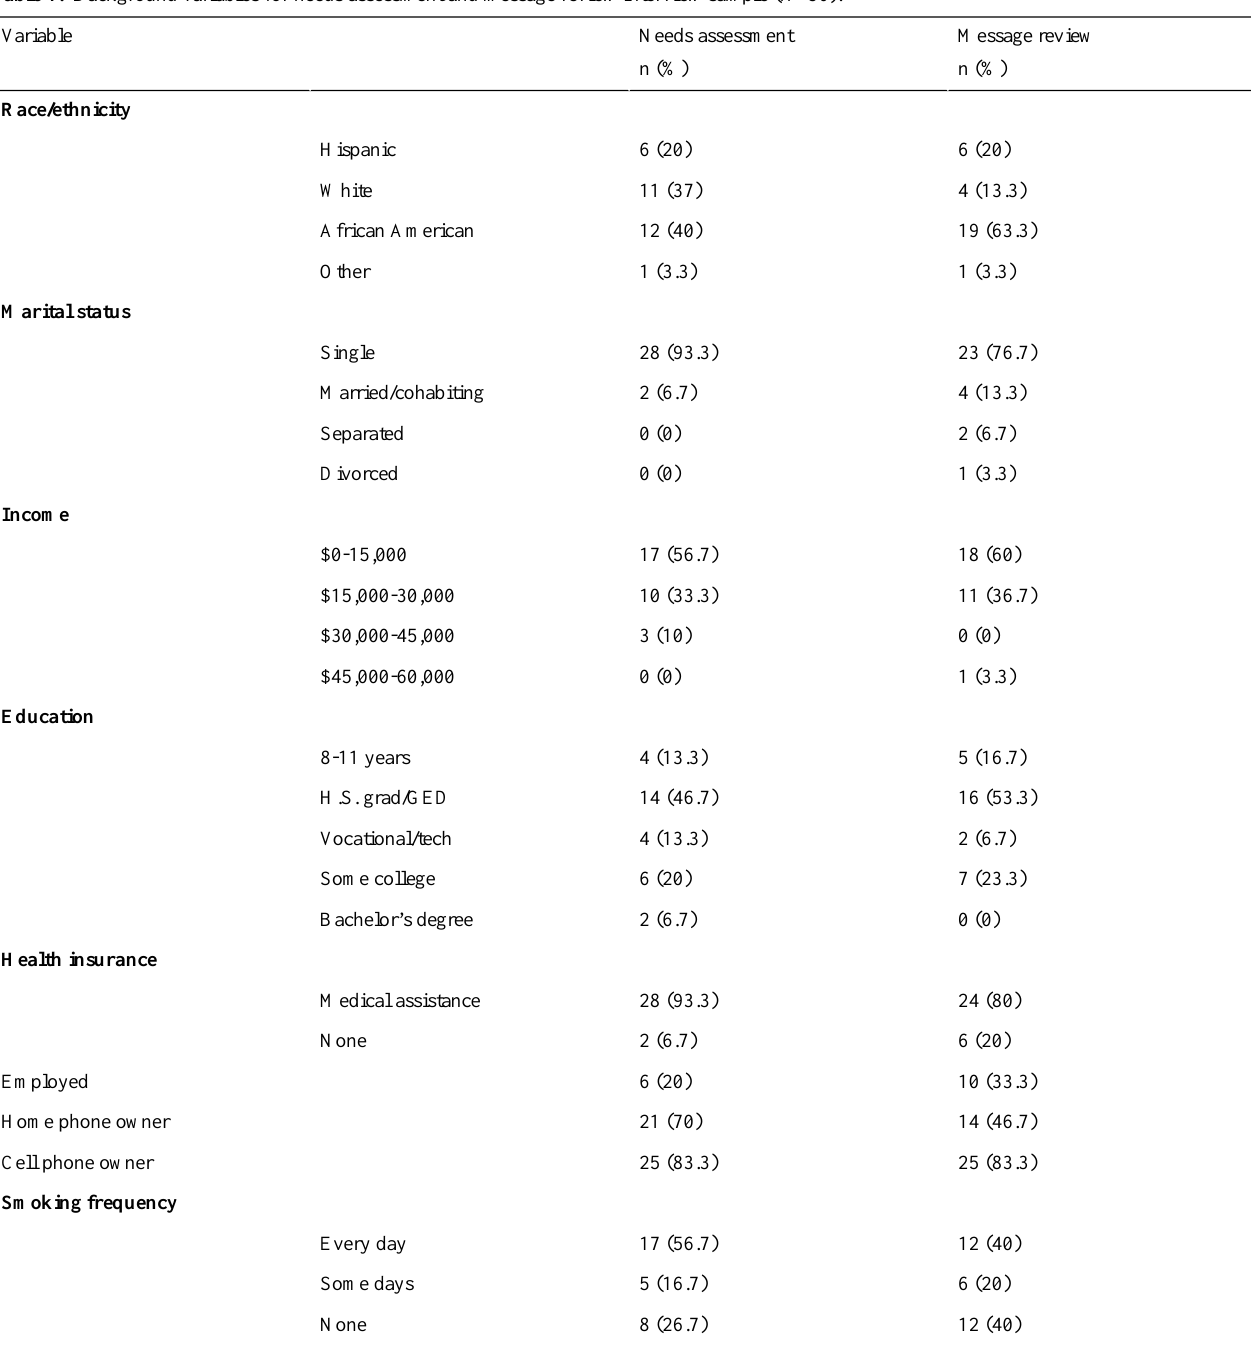
Table 1. Background variables for needs assessment and message review interview sample